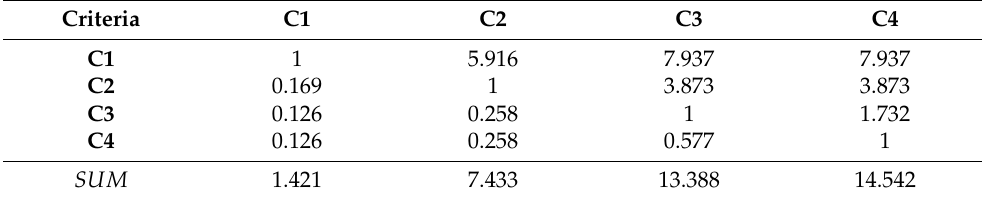
Table 8. Main criteria non-fuzzy comparison matrix.